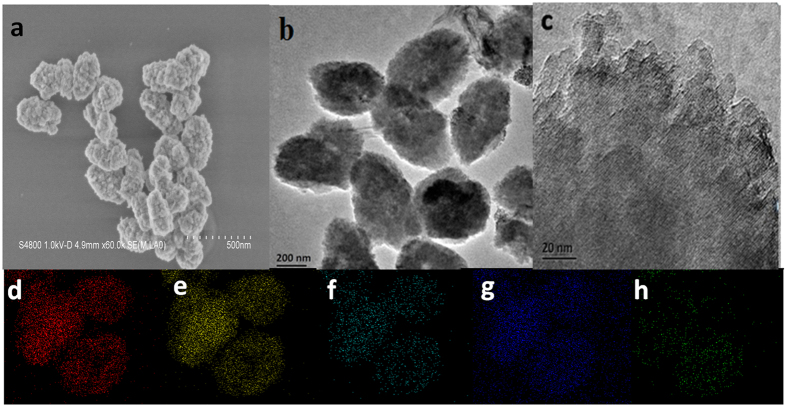
(a) Typical SEM images, (b) low-magnification TEM images, (c) high-magnification TEM images and (d–h) the corresponding element mappings of Si, O, Al, Cu and Bi of Cu1Bi1-mBeta.